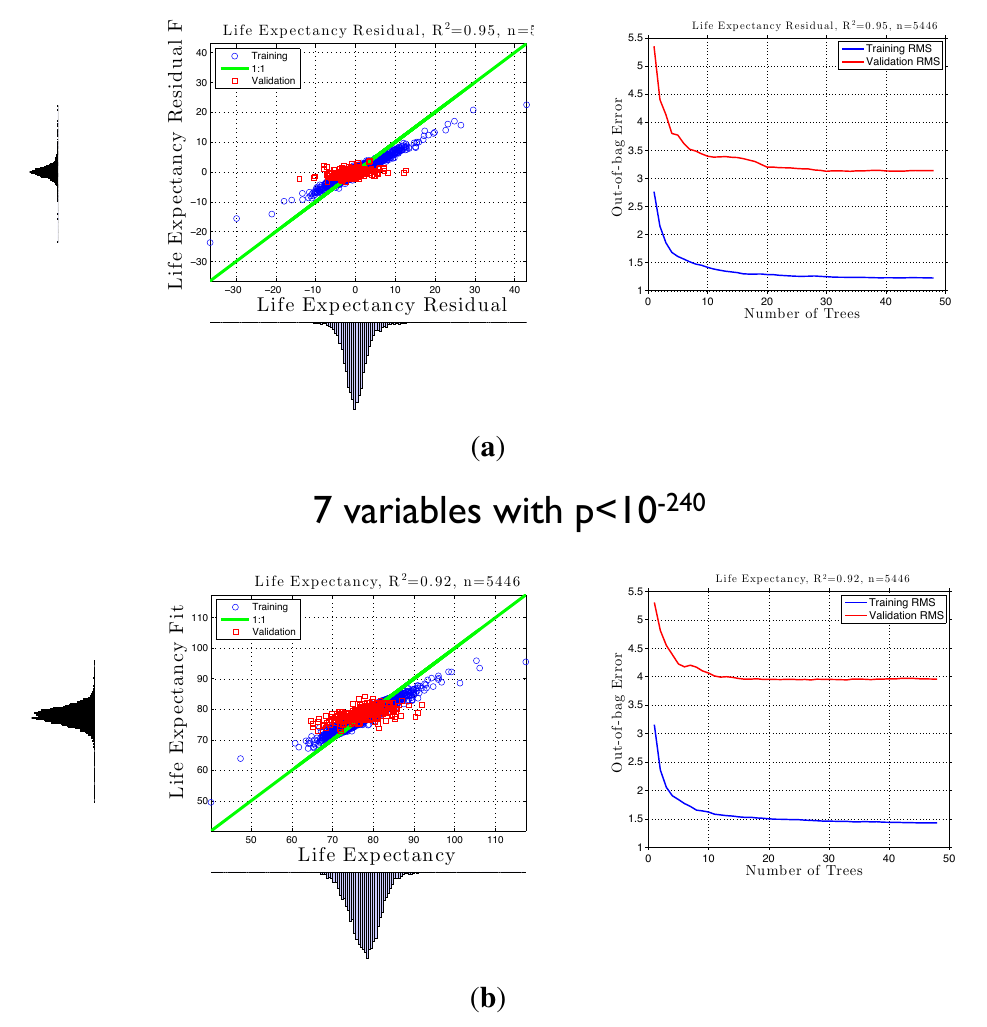
Figure 4. Two examples of the scatter diagrams for fully non-linear, non-parametric, multi-variate estimates of life expectancy: (a) 10,339 variables in the American Community Survey (U.S. Census Bureau) with a bivariate p-value for life expectancy of less than 0.05; (b) seven variables in the American Community Survey (U.S. Census Bureau) with a bivariate p-value for life expectancy of less than 10 − 240 . Blue circles depict the training data. Red squares depict randomly selected, totally independent validation data not used in the training. The green line is the ideal 1:1 line for a perfect